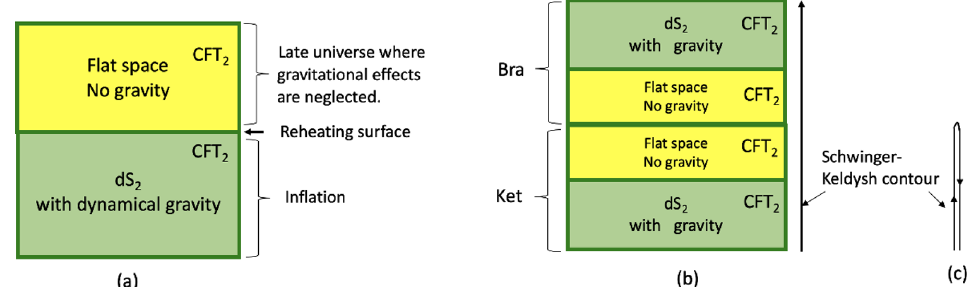
Figure 17 . (a) We study a model which consists of de Sitter gravitational evolution followed by an evolution in flat space with no gravity. (b) When we consider expectation values, we join the bra and the ket following the Schwinger-Keldysh contour. In (c) we see a more traditional depiction of the Schwinger-Keldysh evolution. We go forwards in time to prepare the bra, then go backwards in time to prepare the